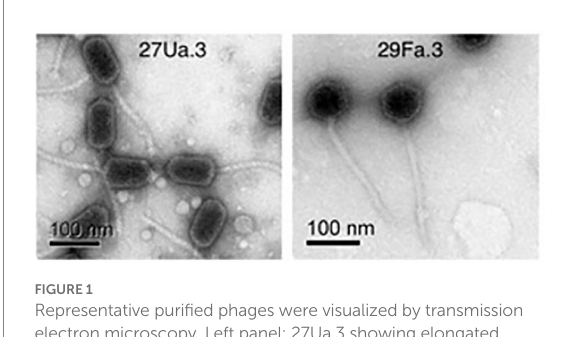
FIGURE 1 Representative purified phages were visualized by transmission electron microscopy. Left panel: 27Ua.3 showing elongated prolate heads with long tails (31Fb.4, and 33Fb.4 not shown had similar morphology). Right panel: 29Fa.3 showing icosahedral heads and long tails.